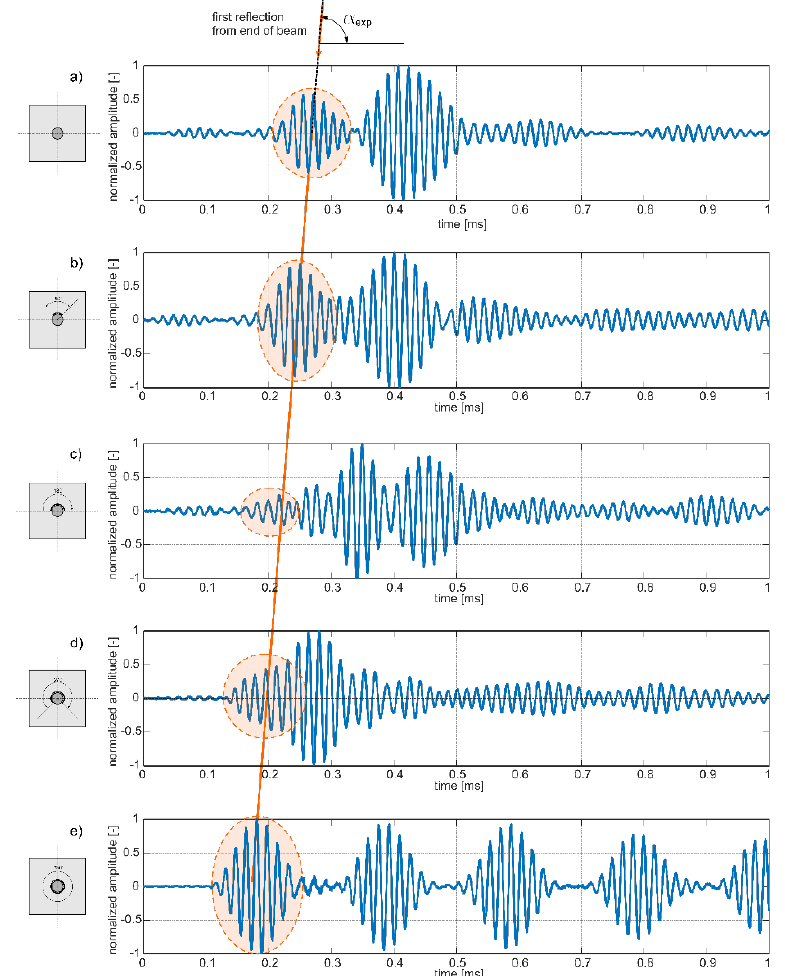
Figure 7. Experimental wave propagation signals registered at the end of the beam with variable circumferential debonding extent: ( a ) undamaged beam and beam with debonding extent of ( b ) 90°, ( c ) 180°, ( d ) 270°, and ( e ) 360° for excitation frequency 60 kHz.